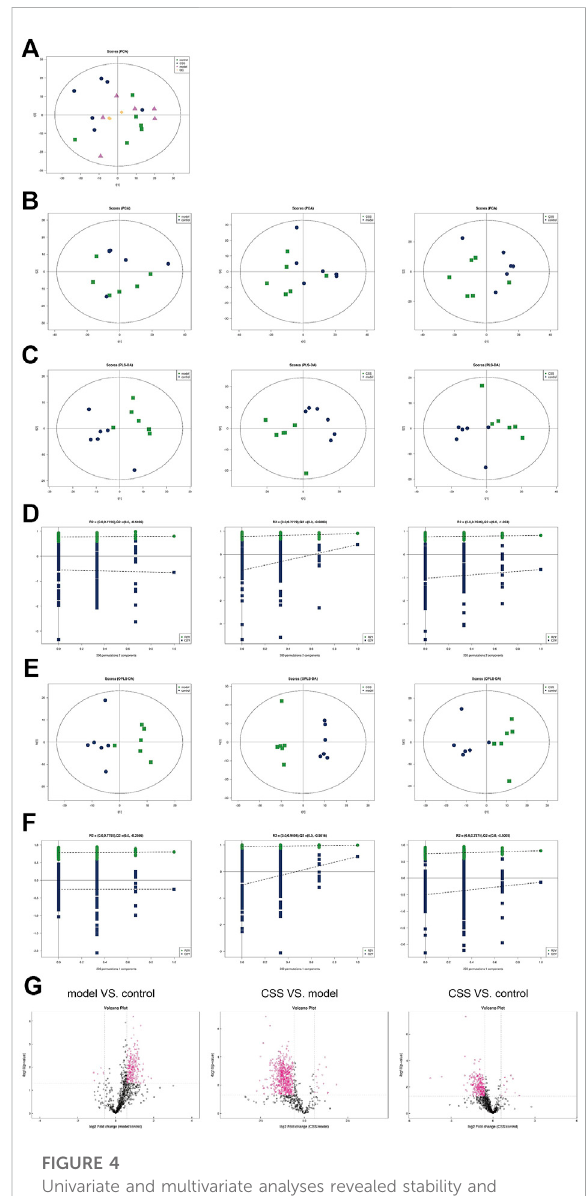
FIGURE 4 Univariate and multivariate analyses revealed stability and reliability of lipidomics method. (A) PCA score plot of all samples andQCsamples. (B) PCAscoreplot (C) PLS-DAscoreplot (D) PLS- DAdisplacementtest. (E) PLS-DAscoreplotand (F) OPLS-DA displacementtestof model-control, CSS-model and CSS-control. (G) ThevolcanoplotsofmodelVS.control,CSSVS.modelandCSS VS. control, red point represents the different lipids (FC > 2.0, p -value <